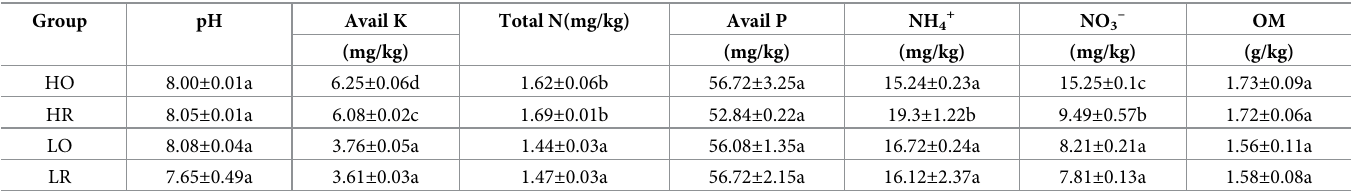
Values are mean ± standard deviation ( N = 3). Values within the same column followed by different letters indicate significant difference ( P <